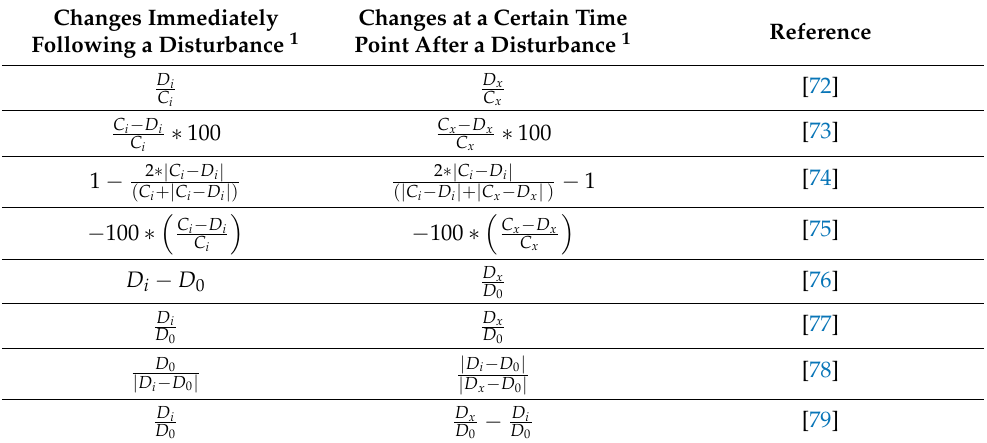
Table 5. Summary of indices to assess changes in community variables following a